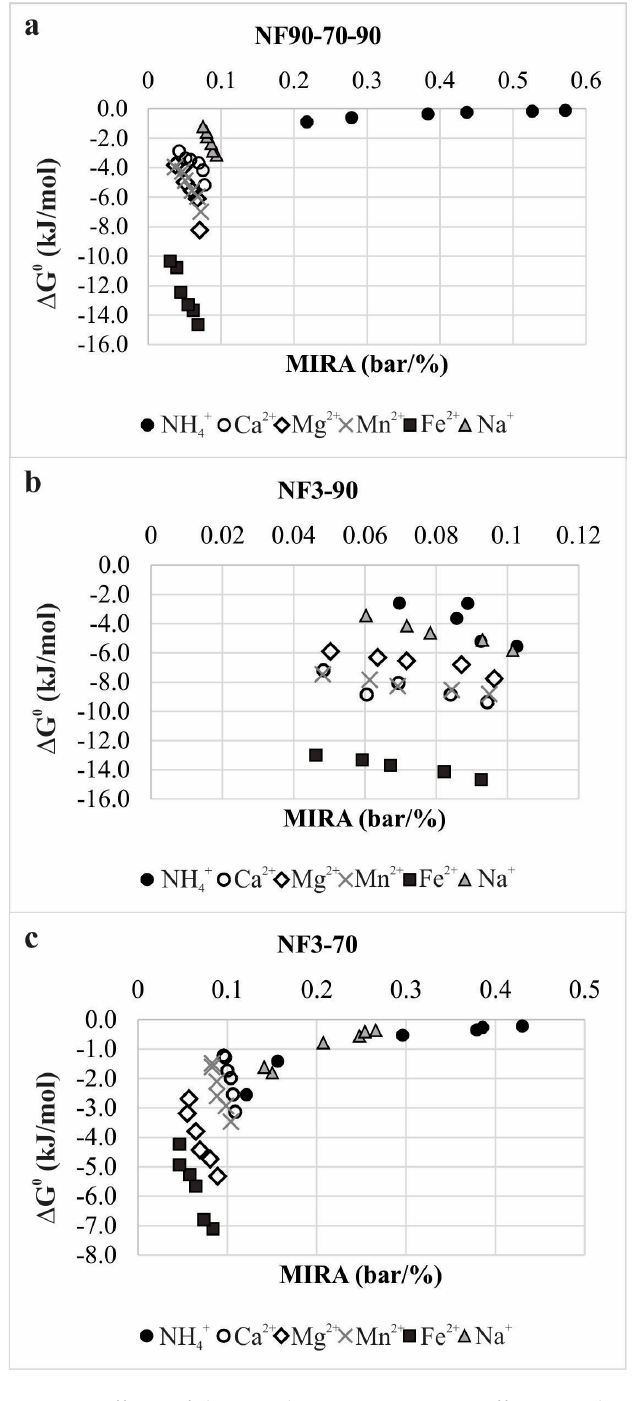
Figure 7. Effects of the membrane ion rejection affinity to changes of the Gibbs free energy at the membrane active layer for NF90-70-90 ( a ), NF3-90 ( b ) and NF3-70 ( c ) experiments. membrane active layer for NF90-70-90 ( a ), NF3-90 ( b ) and NF3-70 ( c )